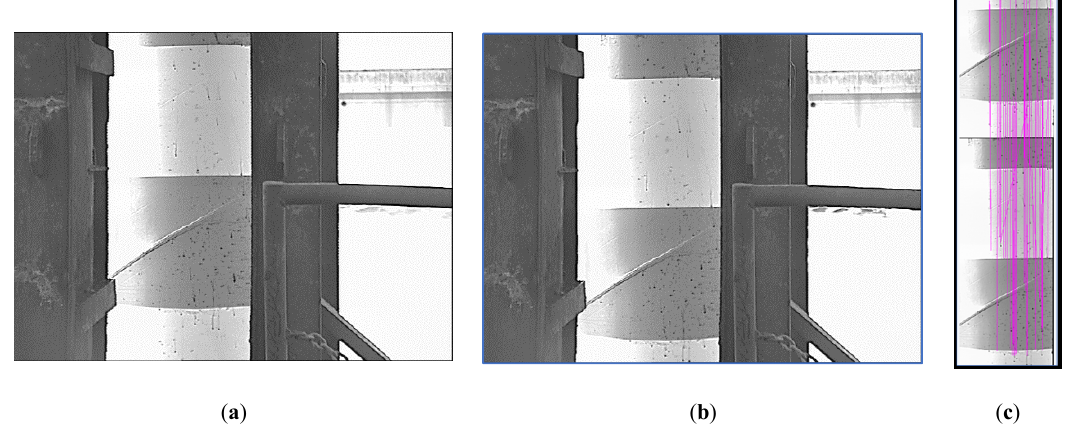
Figure 12. Same points detection from two images before and after hammering: ( a ) Image before hammering; ( b ) Image after hammering; ( c ) Detected same points from two images.